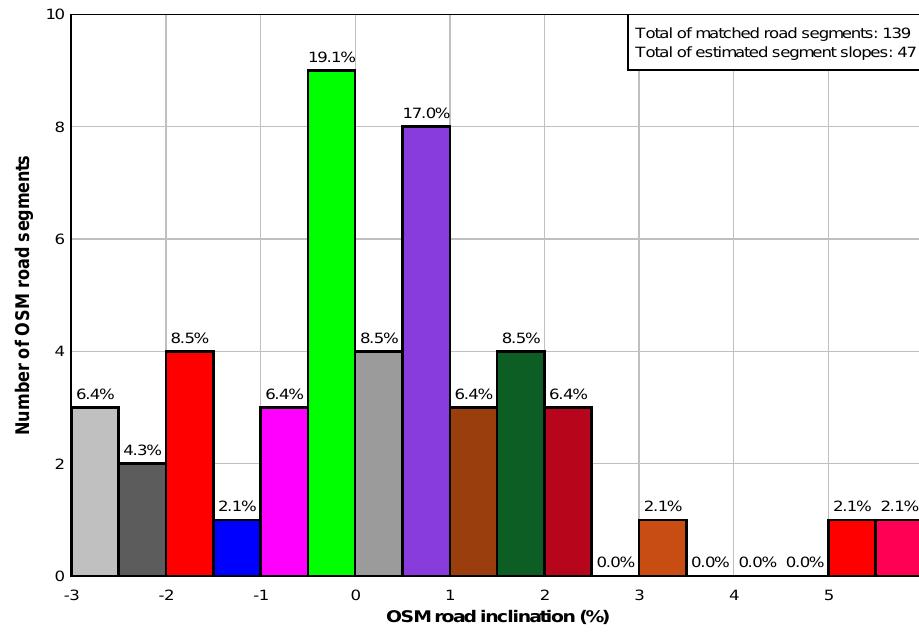
Figure 8. Estimation of the OSM road